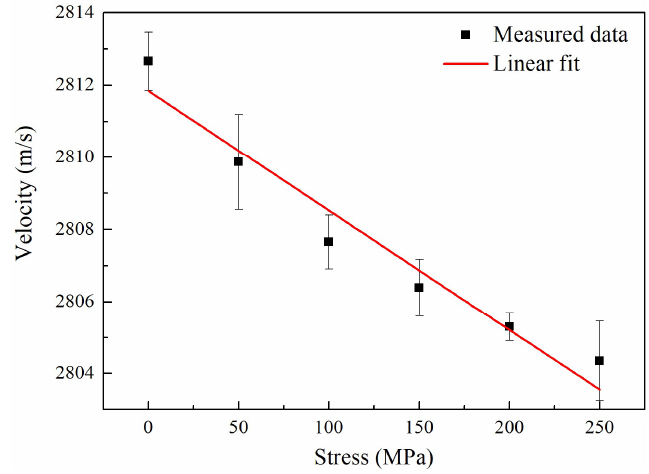
Figure 2. The relationship between the velocity of Rayleigh surface wave and the applied stress.